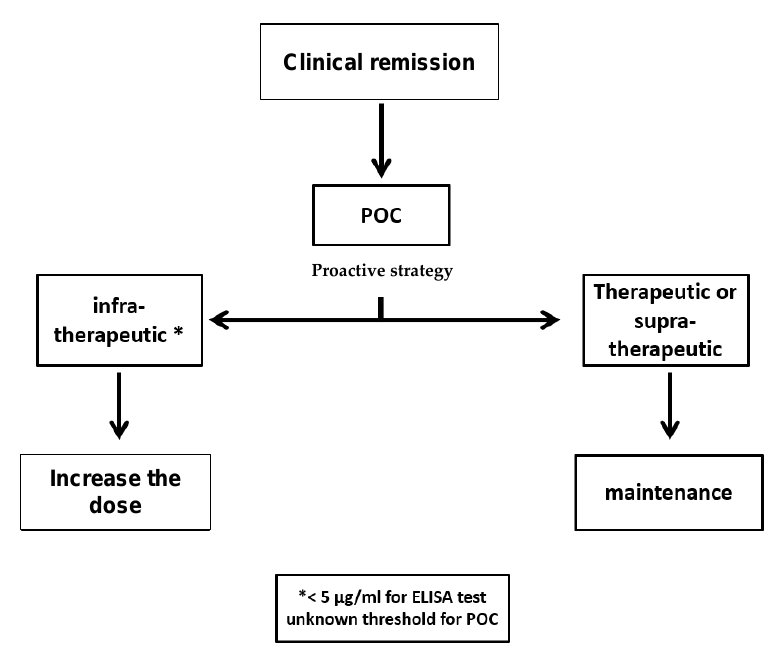
Figure 5. Algorithm for the monitoring of IBD patients in clinical remission. Figure 6. Algorithm for monitoring IBD patients with loss of response .